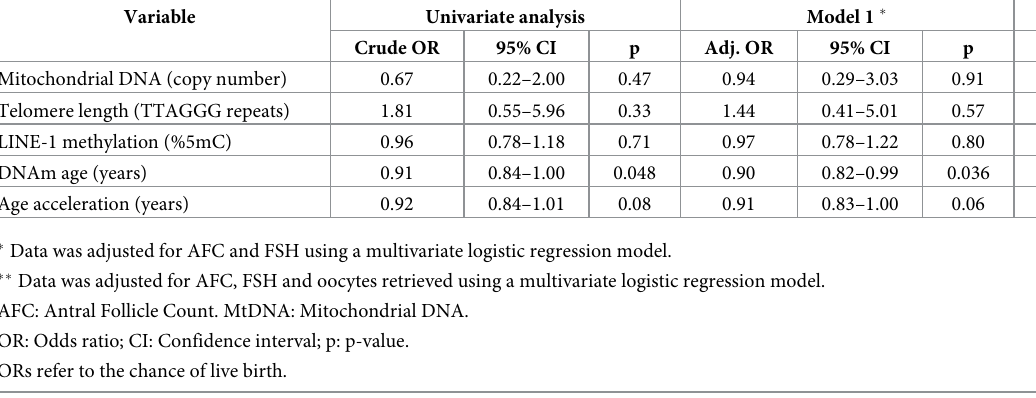
Table 4. Univariate and multivariate analyses on the relation between biomarkers of aging and live birth.